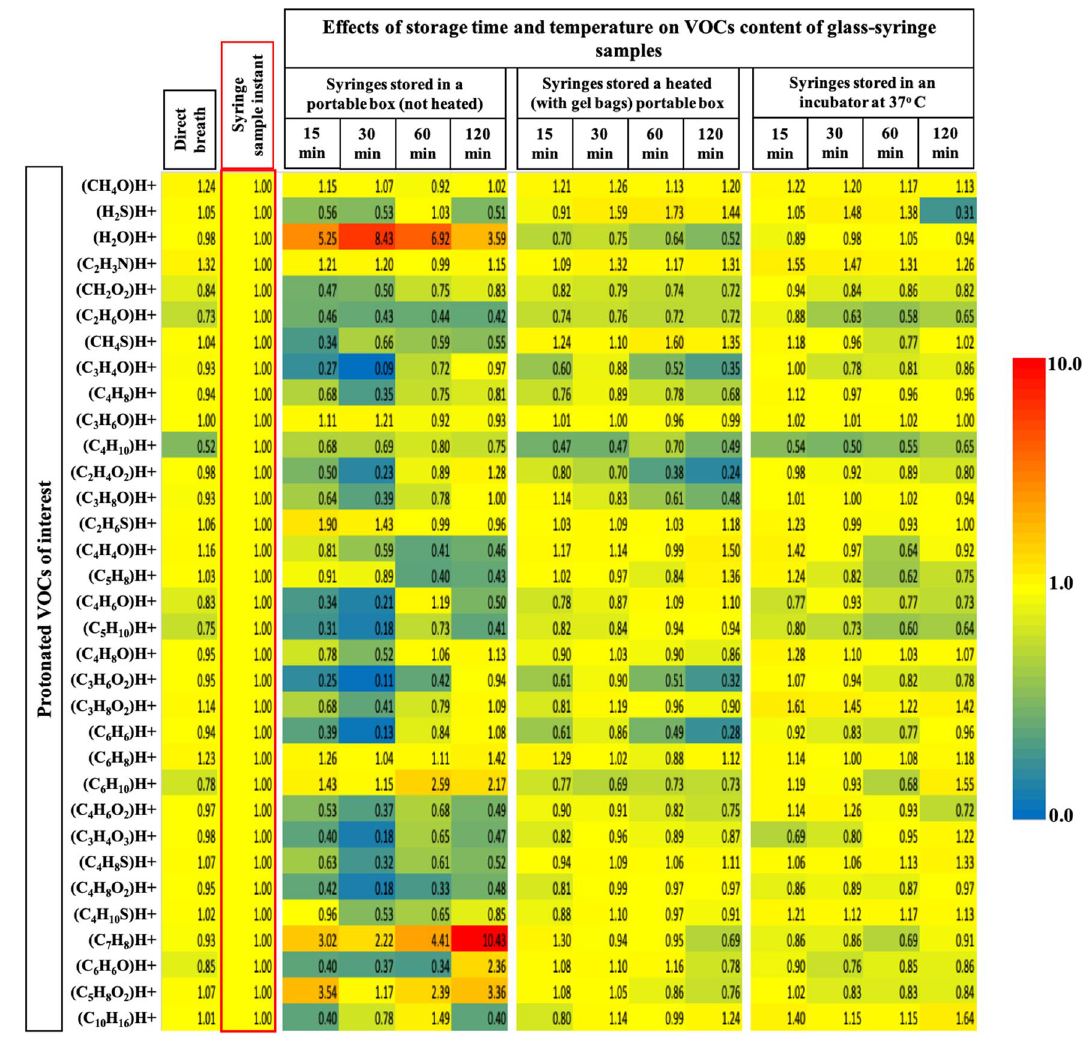
Figure 5. Effects of storage time and temperature of glass-syringe samples onto the VOCs concentrations: Y-axis represents protonated VOCs of interest. X-axis represents experimental conditions. VOCs data (from repeated measurements) were normalised onto the corresponding values from the syringe sample i.e. analysed instantly (without storing). Values from direct breath are depicting syringe-filter driven analytical variations. Effects of storage time of 15, 30, 60 and 120 min on VOCs content are presented along with the effects of storage (for transport) temperature (not heated and heated at 37